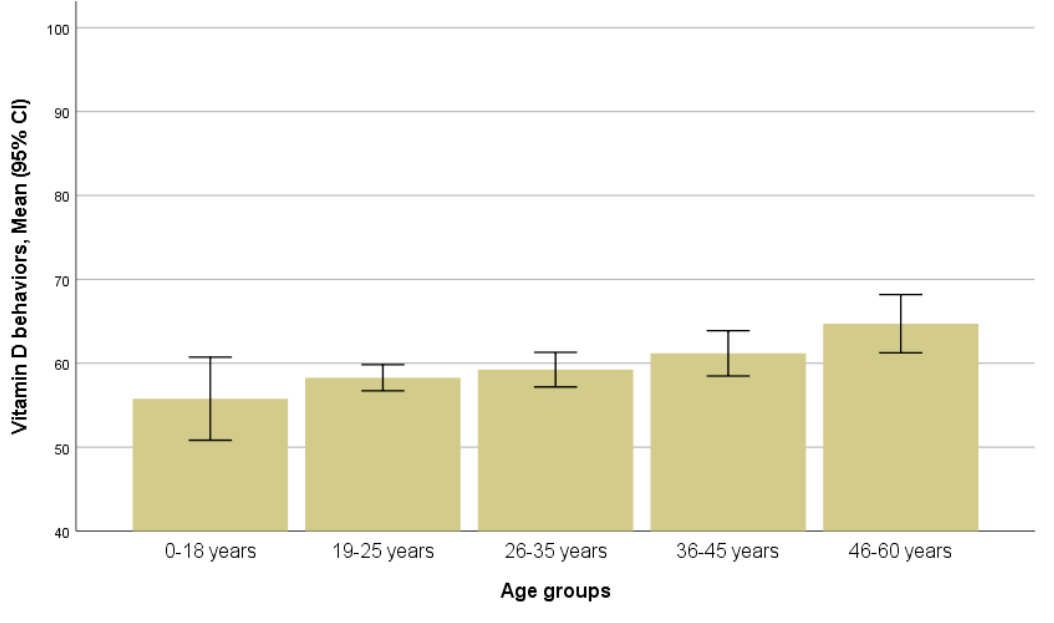
Figure 2. Scores for vitamin D behaviors in age groups (p = 0.022, ANOVA).